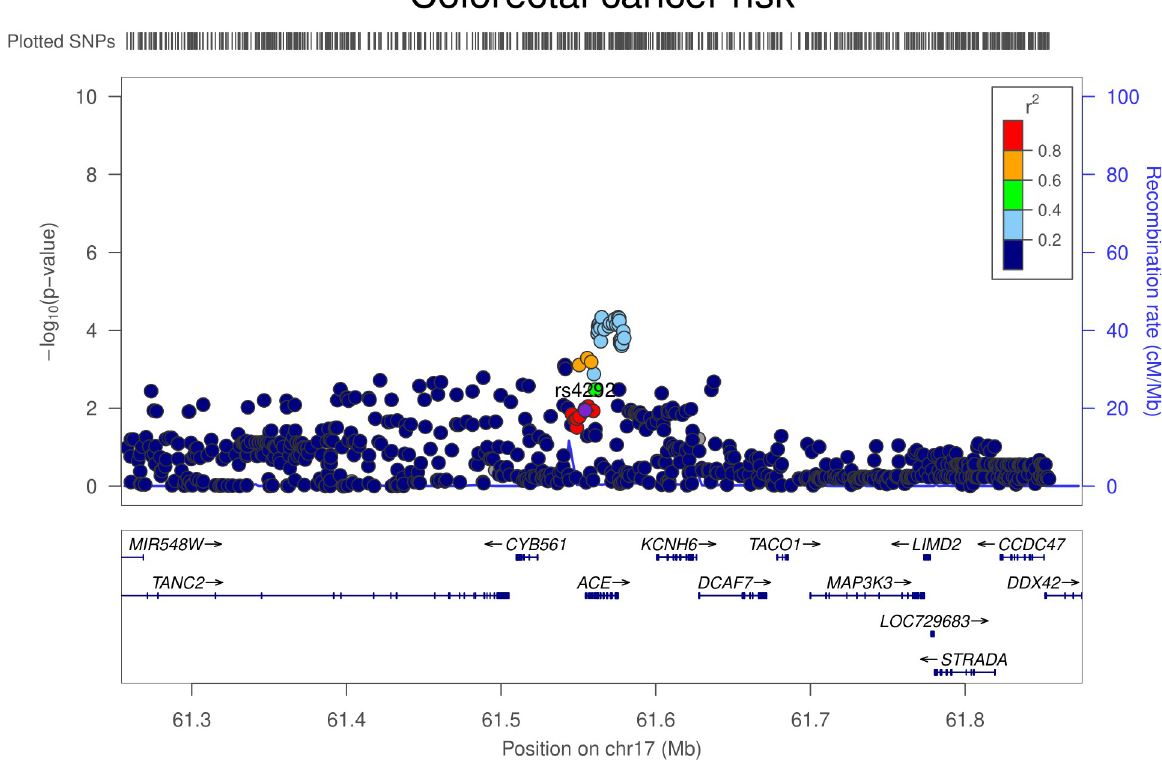
Fig 8. Regional Manhattan plot of associations of SNPs with colorectal cancer risk ± 300kb from the SNP used to proxy colon ACE expression (rs4292) in the ACE region. ACE, angiotensin-converting enzyme; Mb, Megabase; SNP, single-nucleotide polymorphism.